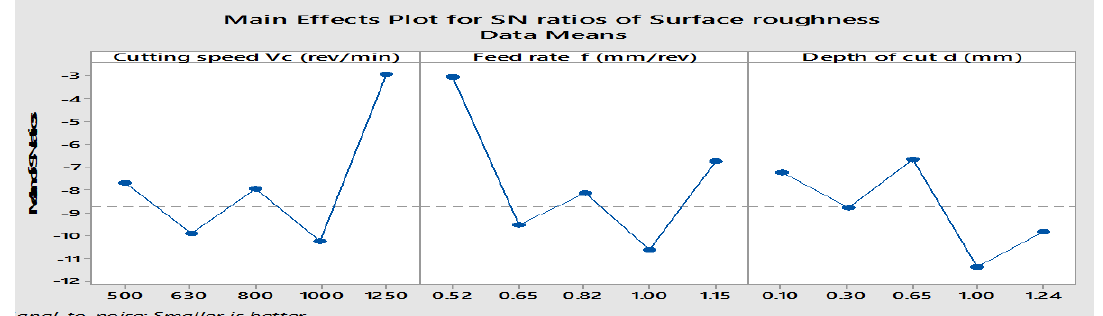
Figure 8: Main effect plot of S/N ratio for surface roughness using MBCF